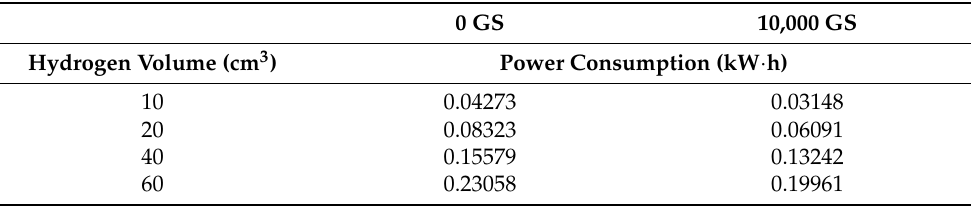
Table 3. Comparison of electric energy consumption needed to produce the same amount of hydrogen from distilled water without pre-magnetic polarization and with 10,000 gs magnetic polarization.